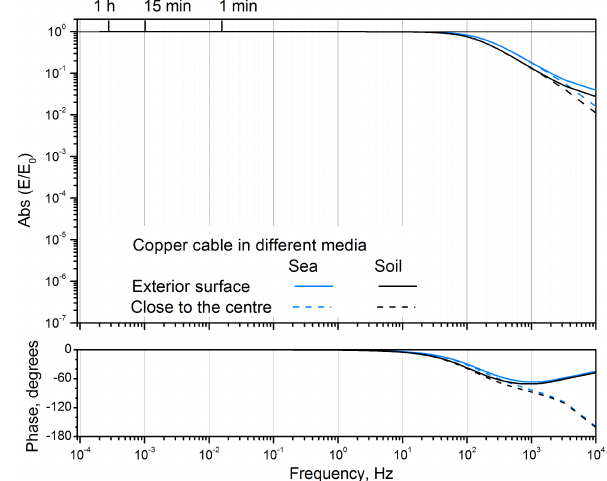
Figure 3. The frequency dependencies of normalized absolute am- plitude (top) and phase (bottom) of the electric field at the outer surface and near the centre of the railway steel. External media is air with conductivity of 10 − 14 Sm − 1 .